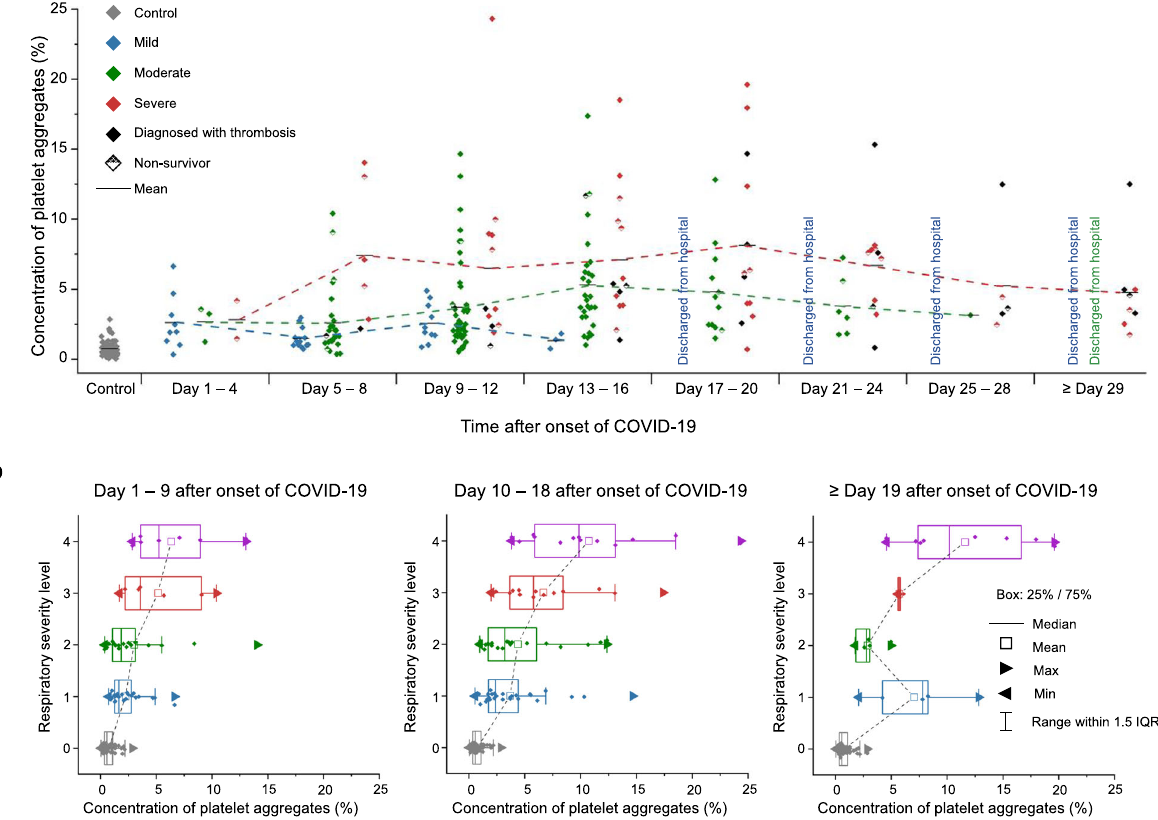
Fig. 6 Temporal monitoring. a Evolution of the platelet aggregate concentrations of different severity groups (mild, moderate, severe). Each patient ’ s highest severity level during his/her hospitalization was used for the severity categorization and fi xed during the entire hospitalization period to trace the evolution of the platelet aggregation concentration of each patient group. b Comparison of the respiratory severity level with the concentration of platelet aggregates ( n = 57 biologically independent samples of Day 1 – 9 after the onset of COVID-19, n = 78 biologically independent samples of Day 10-18 after the onset of COVID-19, n = 21 biologically independent samples of Day ≥ 19 after the onset of COVID-19). The centerline indicates the median, box limits represent the fi rst and third quartiles, and whiskers show all data within 1.5 times the interquartile range (IQR) of the lower and upper quartiles. Minima and maxima are shown with triangle marks. Level 0: control (gray). Level 1: without oxygen administration (blue); Level 2: with oxygen administration of 0.5 – 4 L/min (green); Level 3: with oxygen administration of ≥ 5 L/min (red); Level 4: with mechanical ventilation or ECMO (purple). Source data are provided as a Source Data fi